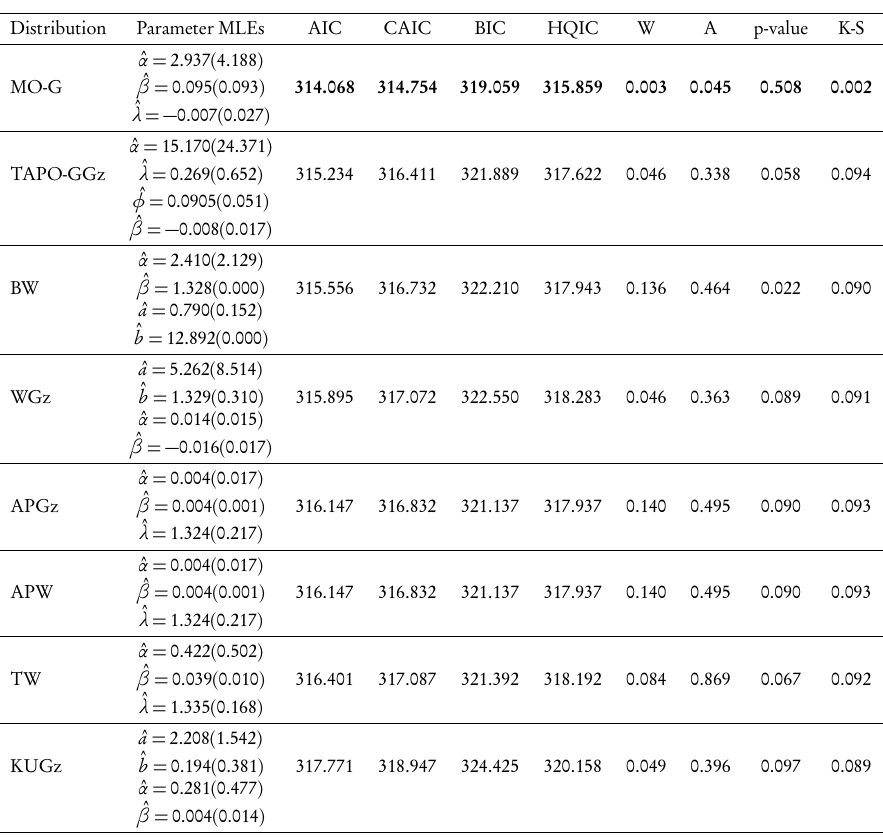
The statistics rating for MO-G distribution with vehicle fatalities dataset with standard errors in